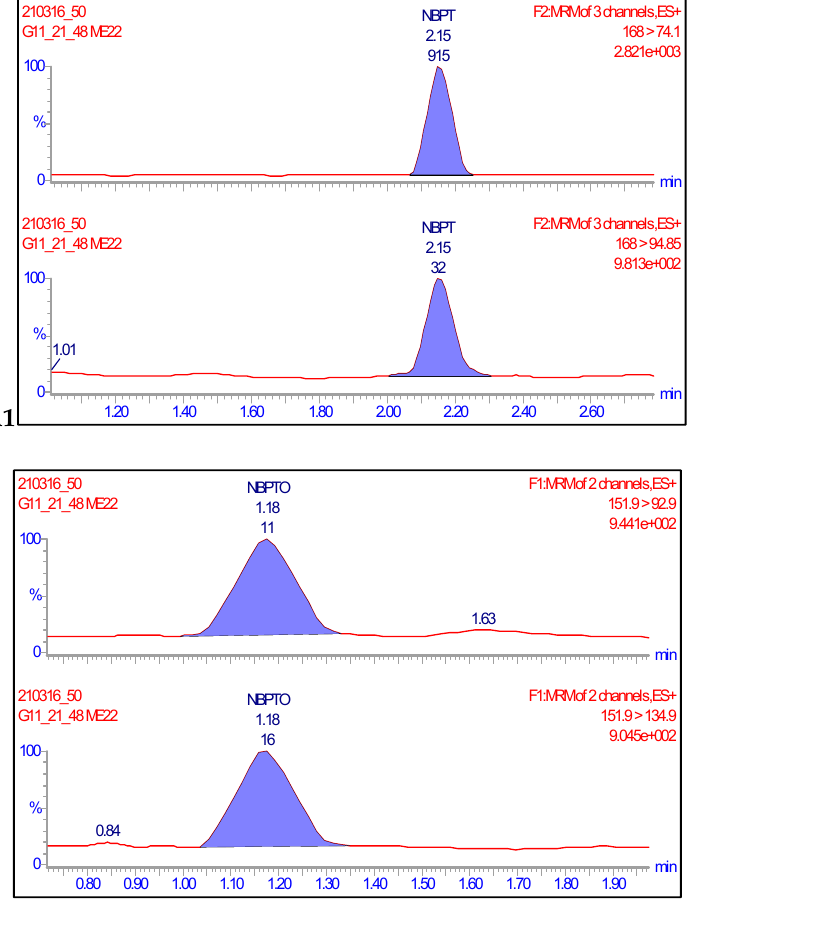
Figure 3. Representative chromatograms of NBPT ( A1 ) and NBPTo ( B1 ) quantifier and qualifier ion transitions spiked in negative milk samples at concentrations of 0.0020 mg kg − 1 and their corresponding blanks NBPT ( A2 ) and NBPTo ( B2 ) showing no isobaric or cross ‐ talk interferences.